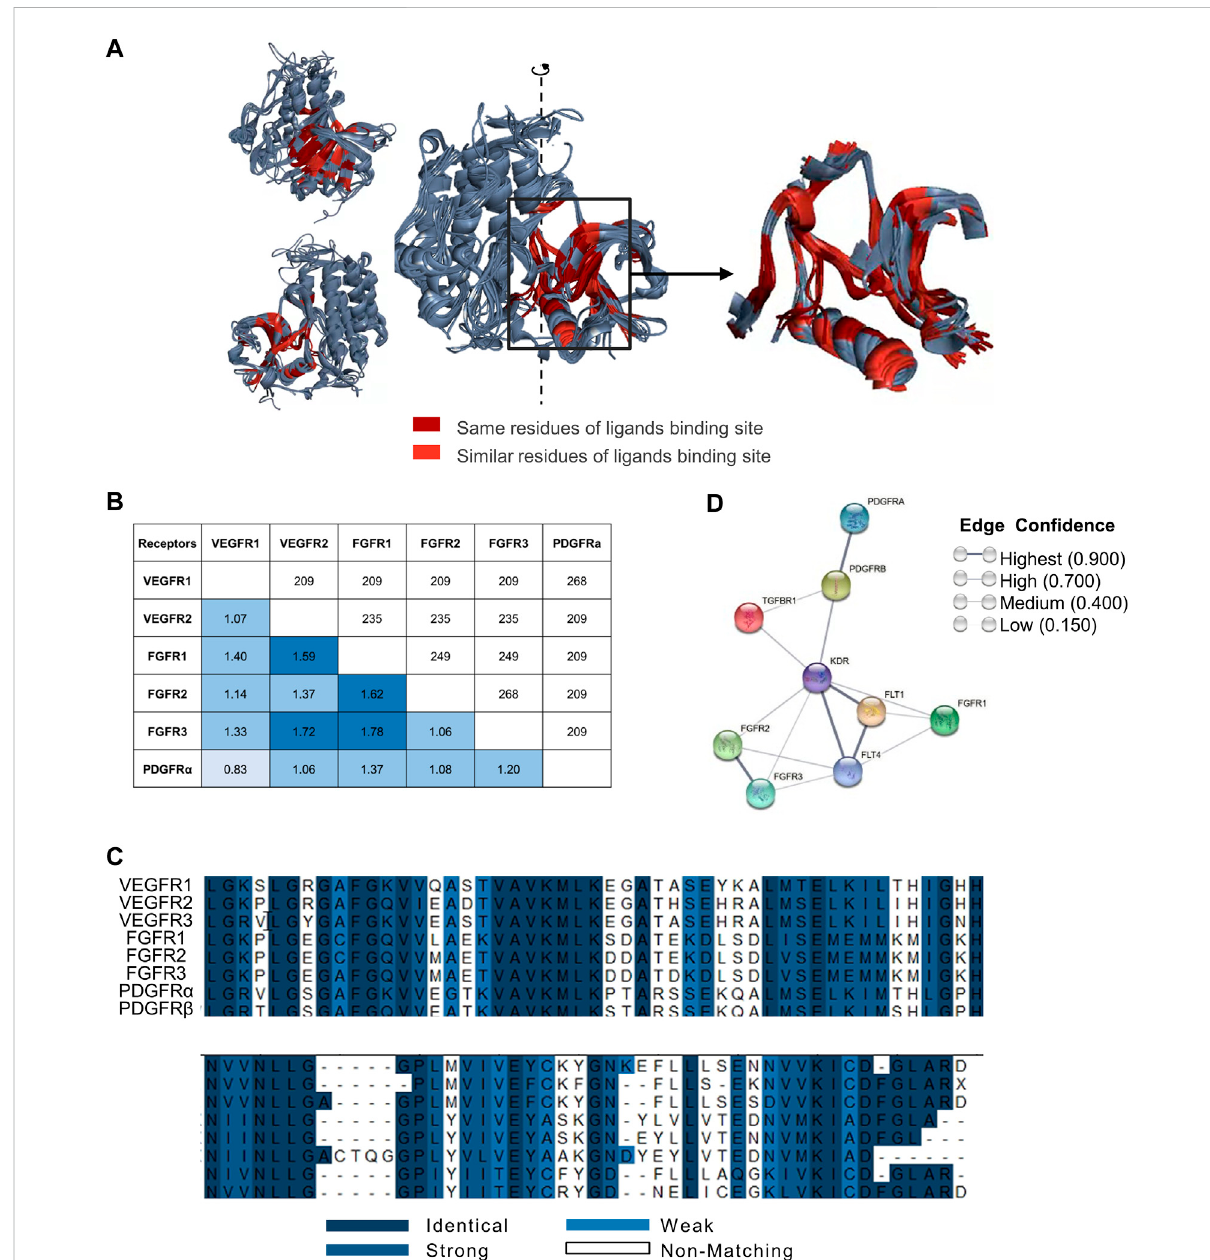
FIGURE 1 Spatialstructuralsimilarity,sequencesimilarity,andphysiologicalpathwayassociationsinninereceptors. (A) SuperimpositionofVEGFRs,FGFRs andPDGFRs.SuperimpositionofVEGFR1/2,FGFR1/2/3andPDGFR α (left)andbindingsites(right).Theligand-boundhydrophobiccavitiesfromeach target and superimposition of the three-dimensional structures of these cavities. We found that the residues in the cavity with the opportunity to contact the ligand are conserved, and the spatial structure is relatively the same. Dark red indicates identical targets, and bright red indicates targets with similar properties. Only the ligand binding domain similarities are marked in the fi gure. (B) Structural alignment of VEGFR1/2, FGFR1/2/ 3 and PDGFR α . The main-chain RMSD (angstrom) is below the diagonal, and the number of overlapping residues is above the diagonal. The main- chain RMSD of these targets was between 0.83 Å and 1.78 Å. Of the approximately 350 residues, there were between 200 and 250 residues with good overlap. This means that the spatial structures of these targets do not differ much. (C) Sequence alignment of VEGFR1/2/3, FGFR1/2/3 and PDGFR α / β . Blueranges from dark to weak, indicating amino acid residues ranging from similar to unrelated. Inthe cavity, theproportion ofthe same residues was 32.3%, and the proportion of similar residues was 54.5%. This suggests that residues of the cavity are conserved. (D) Relevance analysis oftargetsfromtheSTRINGdatabase.Nineproteins(VEGFR1:FLT1,VEGFR2:KDR,VEGFR3:FLT4,FGFR1, FGFR2,FGFR3,PDGFR α :PDGFRA,PDGFR β : PDGFRB and TGF β R1: TGFBR1) were selected from the STRING database. Sphere points replaced several proteins, and line thickness indicates the strength of data support. Each node represents all the proteins produced by a single, protein-coding gene locus. Edges represent protein ‒ protein associations that are meant to be speci fi c and meaningful, i.e., proteins jointly contribute to a shared function; this does not necessarily mean they physically bind each other. Data from the STRING database show that these targets are closely